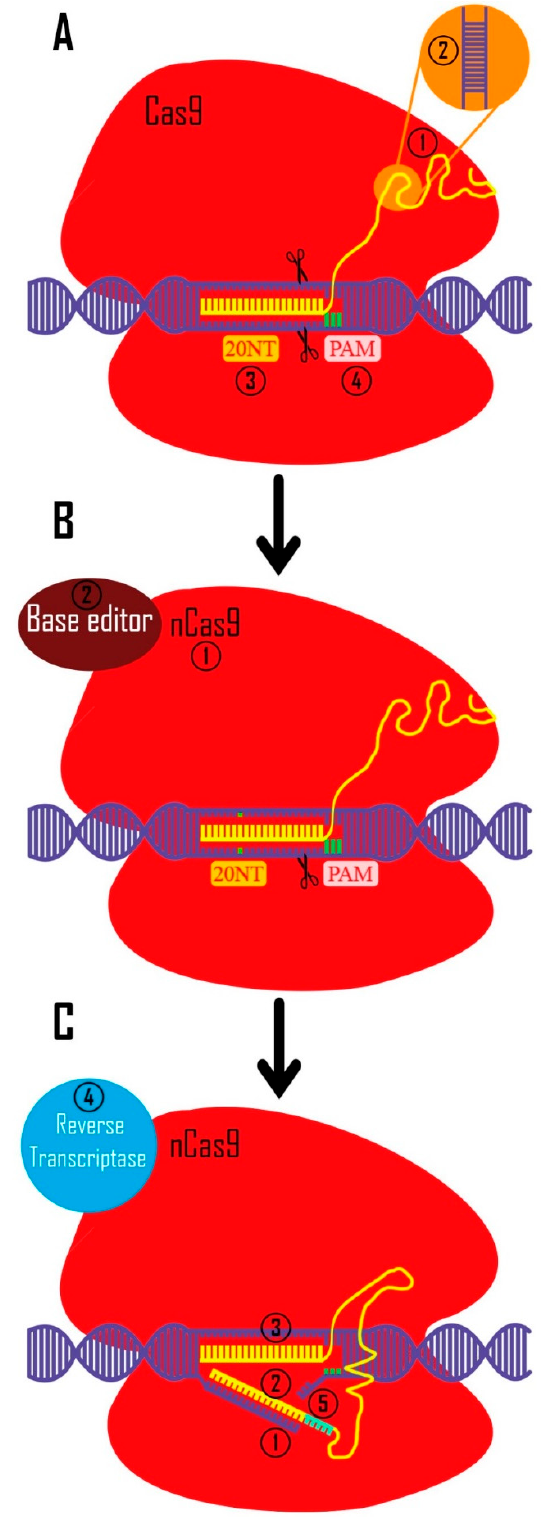
Figure 2. CRISPR toolkit. ( A ). CRISPR technology was originally used to create double-strand breaks in eukaryotic DNA (with a bacterial origin (Streptococcus pyogenes)). 1. In bacteria, crRNA and tracrRNA guide Cas9 to target the intended region. These RNAs are artificially synthetized as a unique sgRNA to be more applicable in other creatures (yellow) 2. crRNA and tracrRNA are widely used in multiple experimental systems (e.g., mouse embryo microinjections, RNP electro- poration into mammalian cell lines, etc.) [91,92] 3. Twenty nucleotides complementary to the target